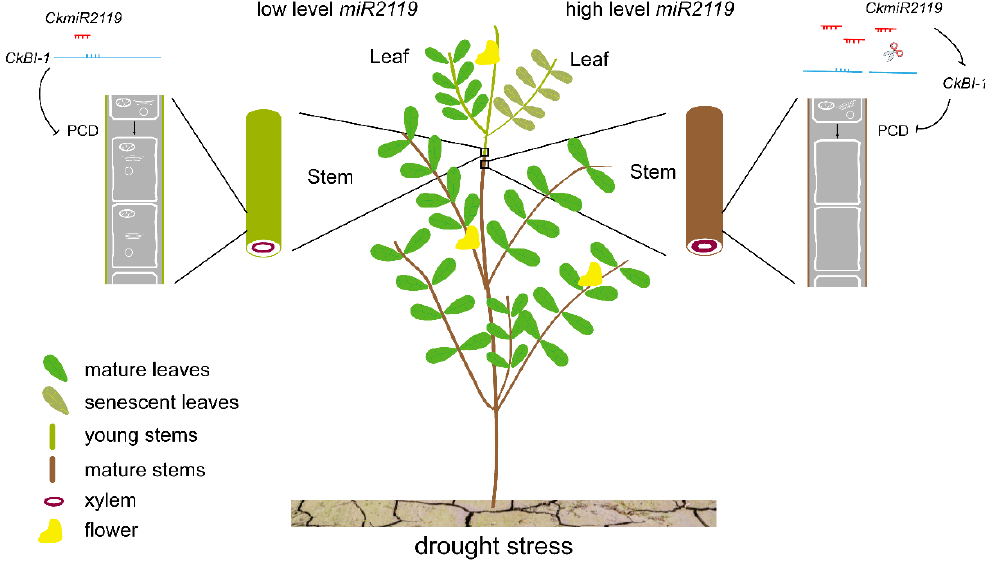
Figure 7. Model of CkmiR2119 regulating CkBI-1 gene expression.